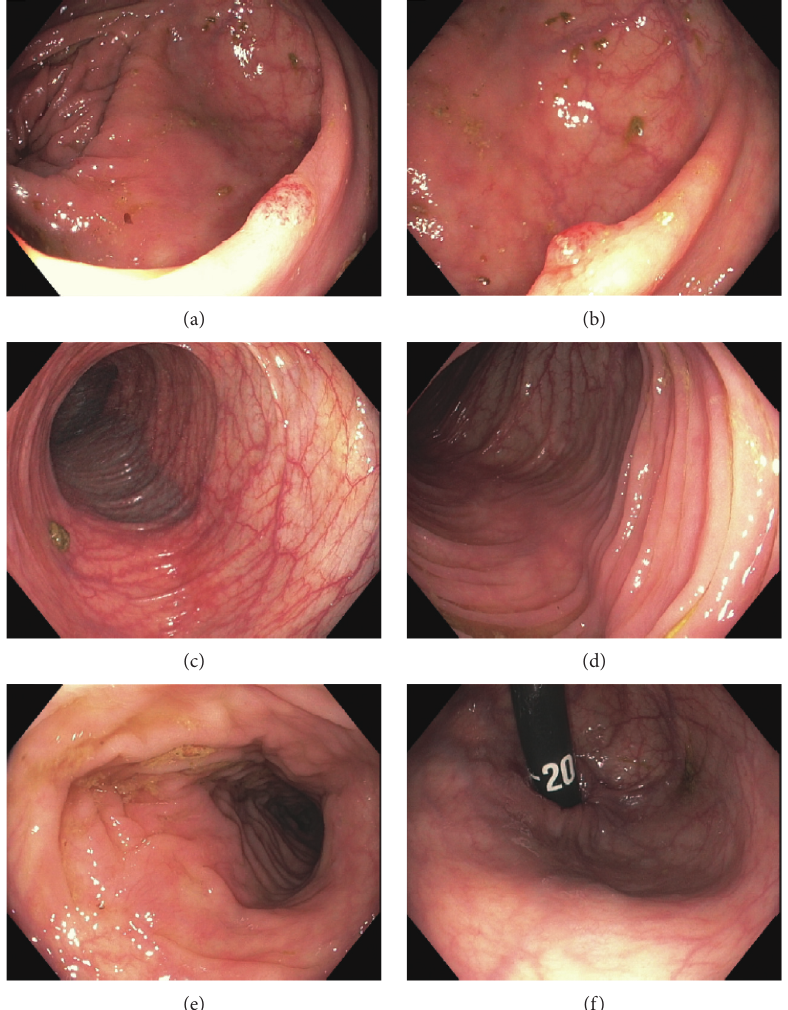
Figure 3: Initial endoscopic images from surveillance colonoscopy 6 days prior to the development of ischemic colitis symptoms. Images are in similar locations to their corresponding letters in Figure 4 for